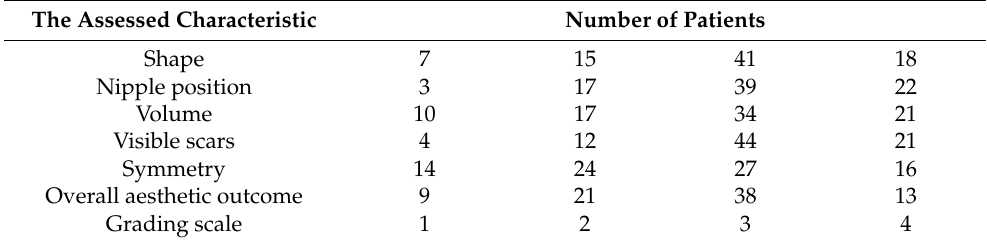
Table A4. The assessment of the outcomes of the operation completed by the doctors 6 months after radiotherapy.